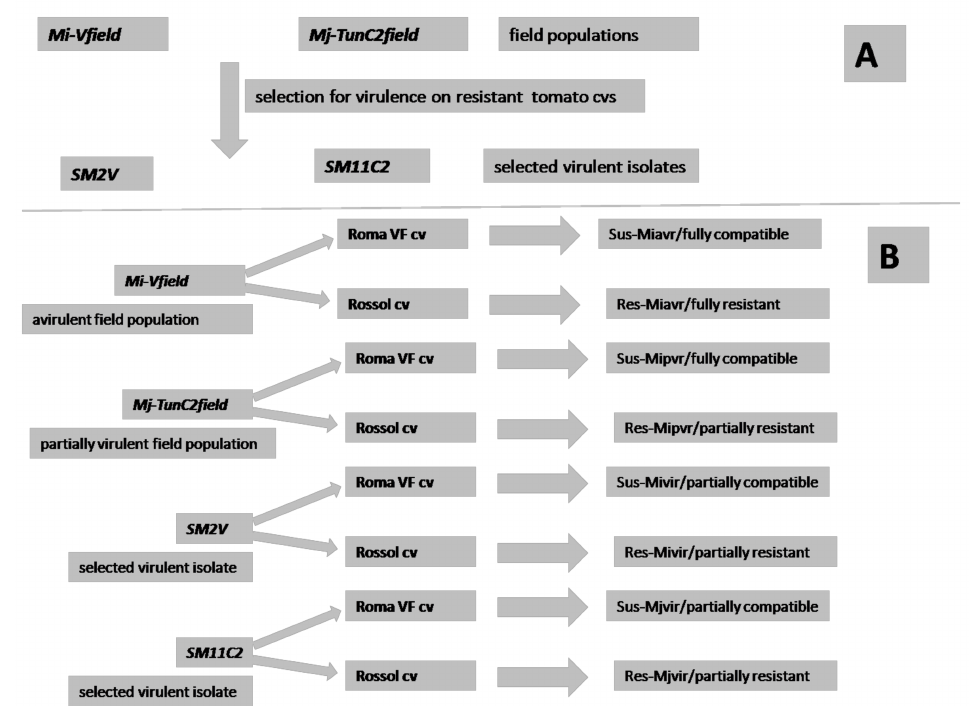
Figure 1. ( A ) Scheme of the selection for virulence to which the field populations Mi-Vfield and Mj-TunC2field were subjected to obtain the virulent isolated SM2V and SM11C2 ; ( B ) scheme of the nematode-plant interactions realized in this study.